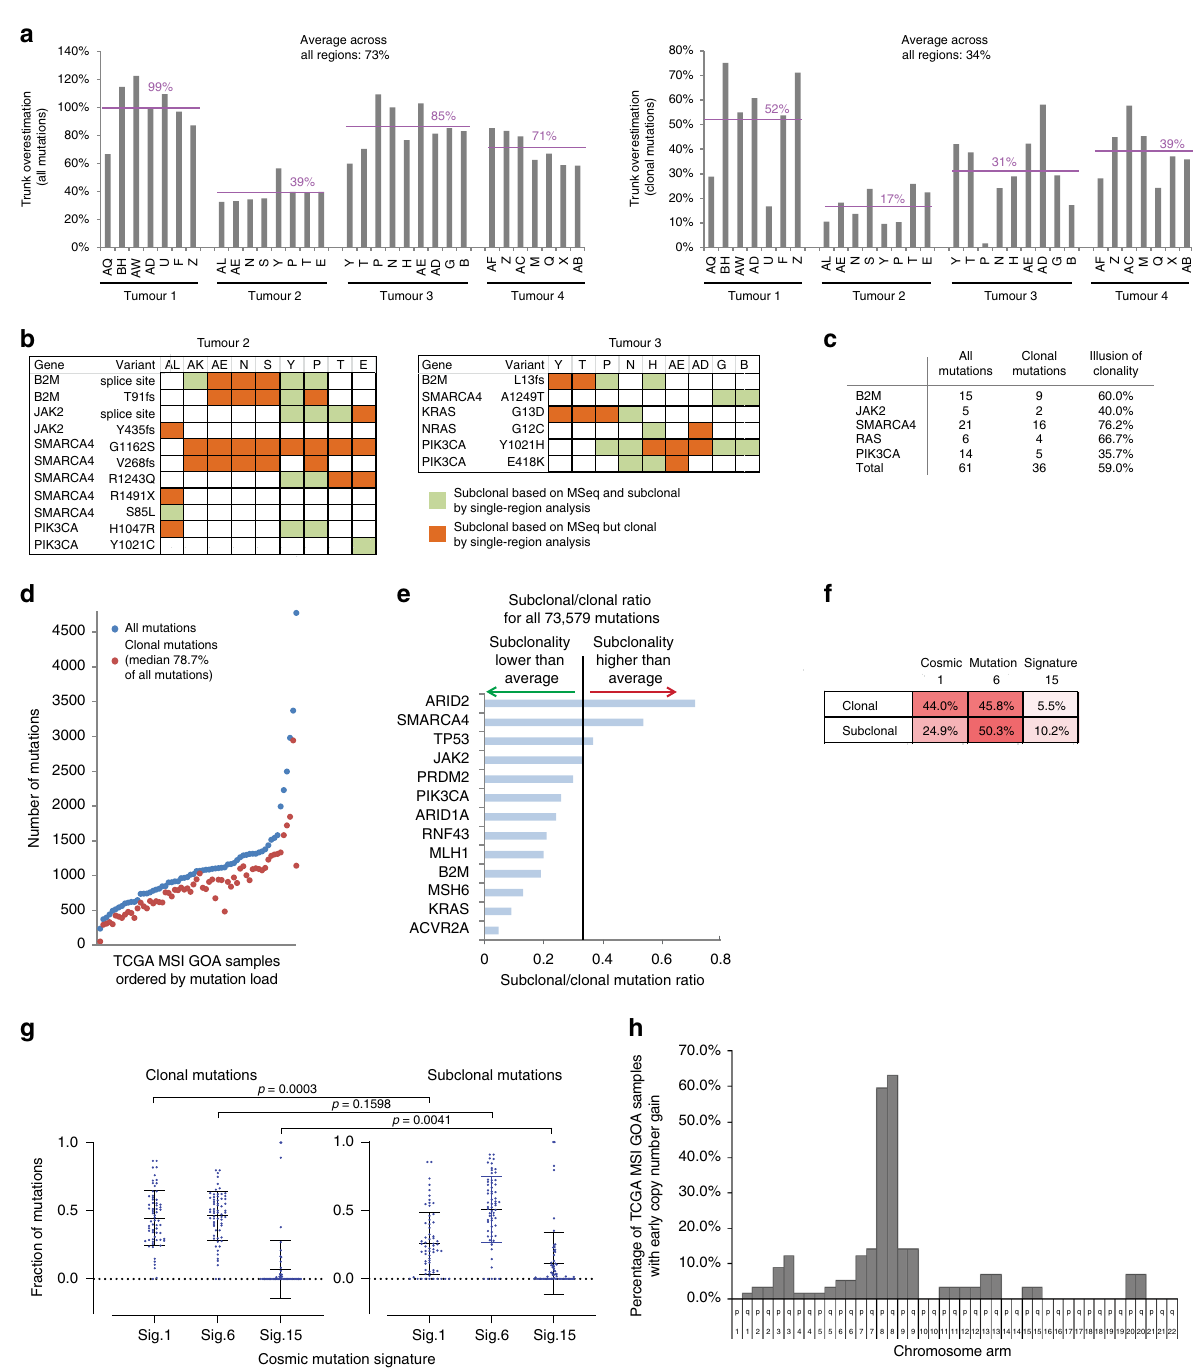
Fig. 6 Clonal and subclonal mutation analysis. a Comparison of the total non-silent mutation load per region and of the clonal mutation load per region (de fi ned as present in a cancer cell fraction (CCF) of 0.7 or above) against the number of ubiquitous mutations that have been identi fi ed by MSeq. The percent difference to the ubiquitous mutation load is shown. b Subclonal driver gene mutations assessed by MSeq in Tumours 2 and 3. In green mutations that single-region analysis picks up as subclonal and in orange mutations that would have been falsely assigned as clonal by single-region analysis. c Illusion of clonality (in percent) for driver gene mutations. d Mutation load of TCGA MSI GOA samples, number of all mutations in blue and of clonal mutations in red. e Subclonal to clonal mutation ratio for driver gene mutations. The black line shows the average ratio across all somatic mutations. f Mean percentage of clonal and subclonal mutational signatures found in TCGA MSI GOA samples. g Subclonal and clonal mutational signatures for 64 TCGA MSI GOAs. Means and standard deviation are shown and p -values have been calculated with a Mann – Whitney test. h Percentage of the 64 TCGA samples that gained the indicated chromosome arm early, i.e. before a high number of mutations was acquired through